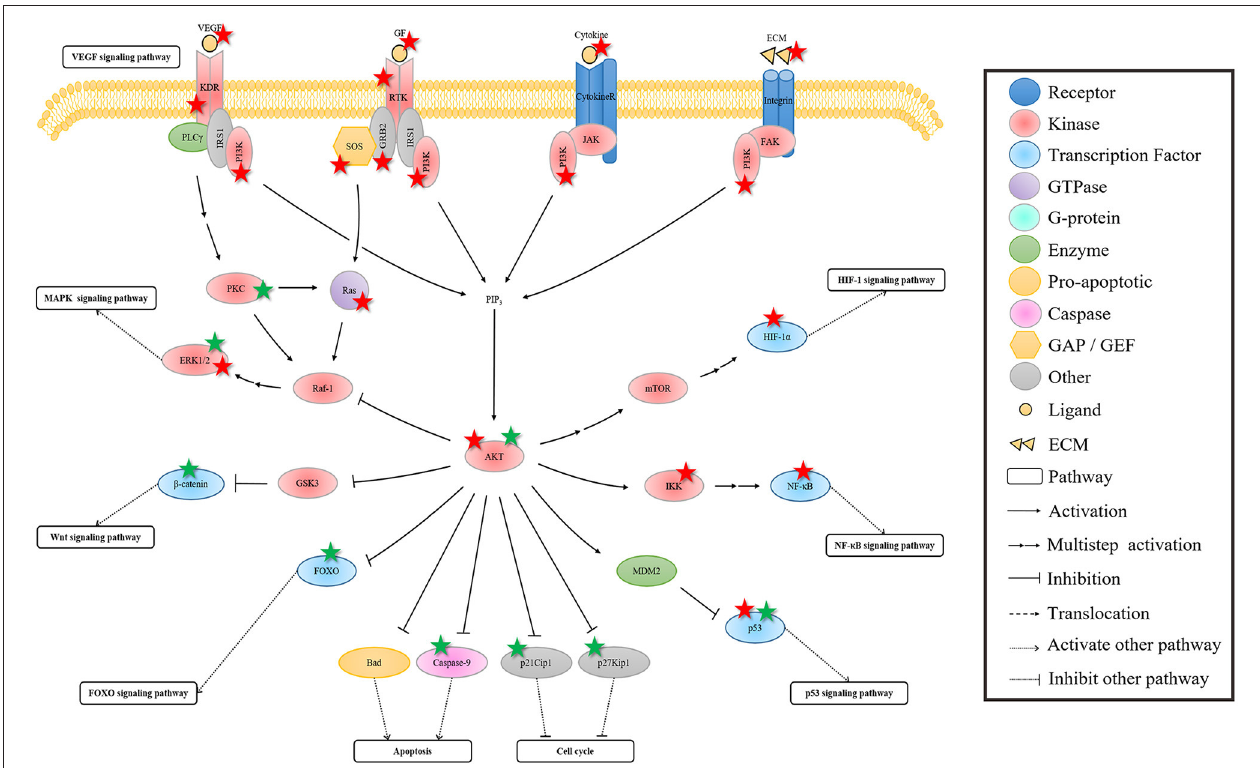
FIGURE 4 | The regulation of rhein on the crosstalk of PI3K-AKT signaling pathway. In this pathway, AKT is the bridge of the extracellular signal and the nuclear gene expression, affecting some of its downstream pathways. The regulation of rhein on these pathways is probably because of the indirect influence of rhein through hub AKT protein mediation or the direct action to the AKT downstream protein. The protein marked with star is the target of rhein. Red and green star represent negative and positive regulation,